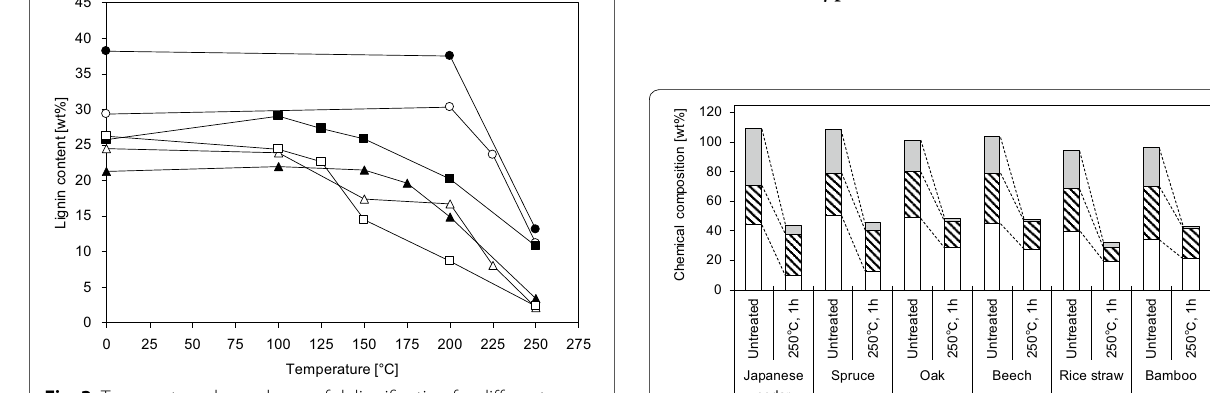
Fig. 3 Temperature dependence of delignification for different biomasses with 20% sodium oleate in glycerol. Symbols: filled circle, Japanese cedar; open circle, spruce; filled triangle, oak; open triangle, beech; closed square, rice straw; open square, bamboo. Data at 0 °C show lignin content of raw biomass